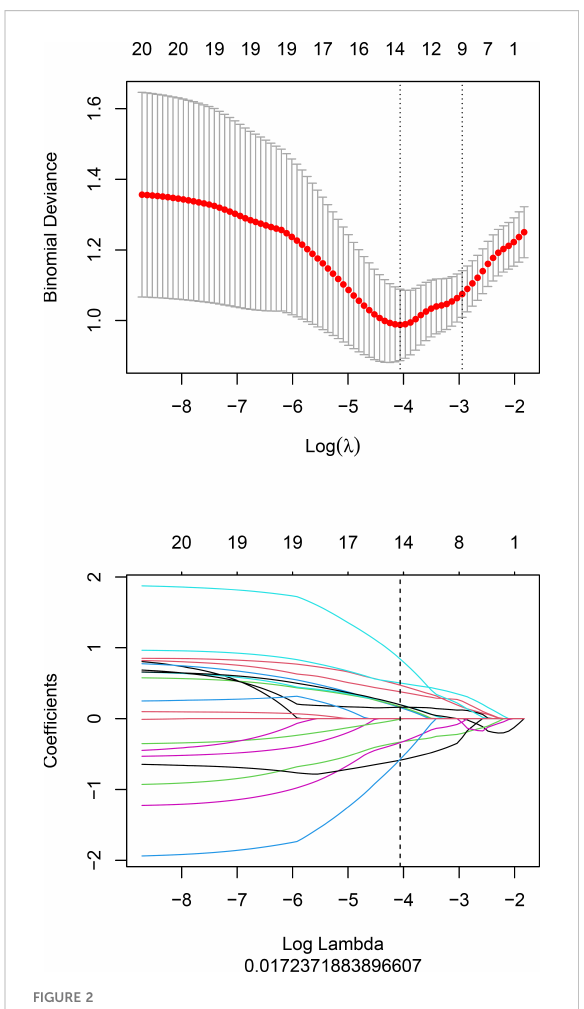
FIGURE 2 Feature selection for the LASSO logistic